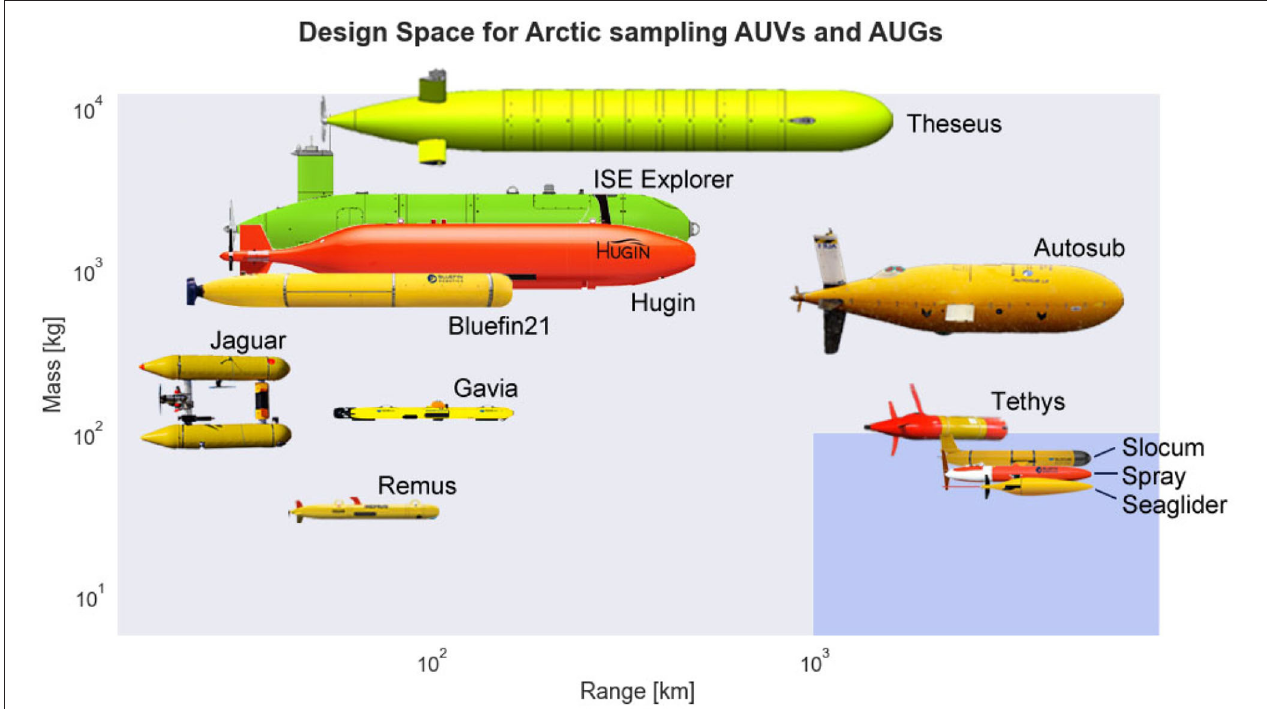
FIGURE 1 | Overview of design space for under-ice surveying autonomous underwater vehicles (AUVs) and gliders in terms of mass and range. This trade space includes several size classes of underwater vehicles: extra large vehicles such as Theseus (Butler and den Hertog, 1993), large vehicles such as ISE Explorer, Hugin, Bluefin21, and Autosub (Kaminski et al., 2010; Furlong et al., 2012; Lehmenhecker and Wulff, 2013; Graham et al., 2019), medium vehicles such as Jaguar, Gavia, and Tethys (Wadhams and Doble, 2008; Kunz et al., 2009; Bellingham et al., 2010), and small vehicles such as Remus, Slocum, Spray, Seaglider (Sherman et al., 2001; Kukulya et al., 2010; Jones et al., 2014; Lee et al., 2017 ). The blue highlighted region indicates the area of interest within the design space: vehicles of modest size that can support meaningful payloads while maintaining long-range capabilities. The top-right corner of each vehicle image indicates its approximate numerical value within the design space. The scaling and relative position of the vehicle images is